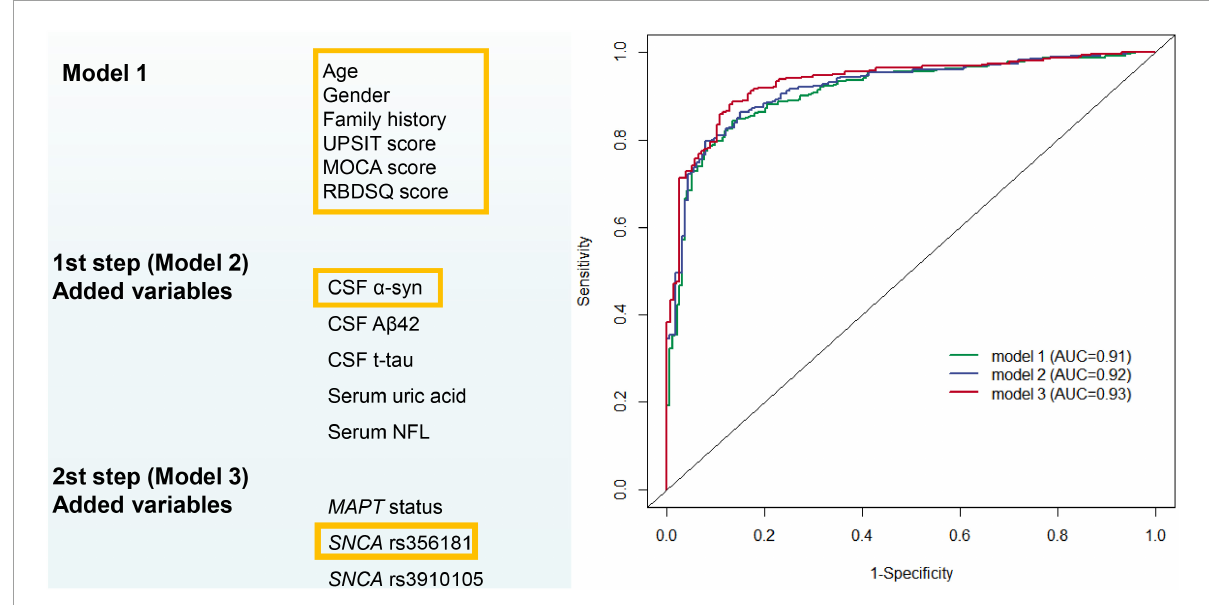
FIGURE2 Predictive modeling for distinguishing between early Parkinson’s disease and healthy normal. AUC, area under receiver operating characteristic